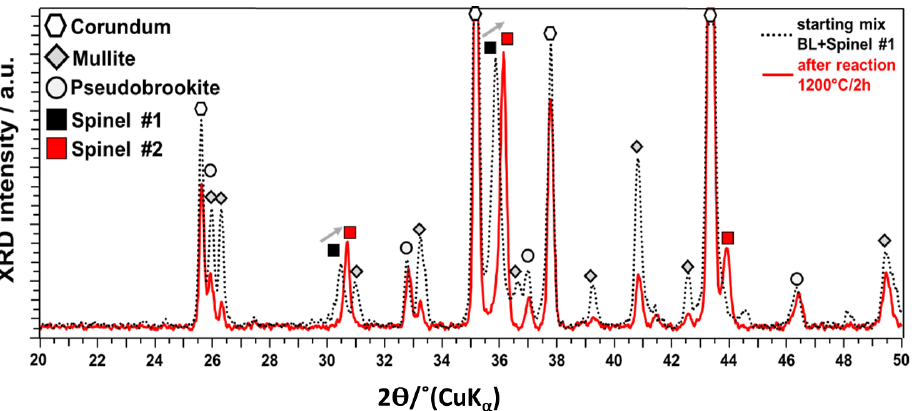
Figure 4. XRD profiles of mixed bauxite-type proppant and spinel-type powders before and after sintering (2h/1200 °C). Tick marks show a significant shift of spinel peaks toward higher 2-values (squares) and massively decreasing peak intensities of mullite (diamonds). Figure 5 represents microstructural features and overlayed EDS mappings of the BL proppant before and after deep-black pigment coating. Typical proppant morphology comprising corundum particles, iron bearing crystals and the surrounding glass matrix was not substantially affected by the coating process